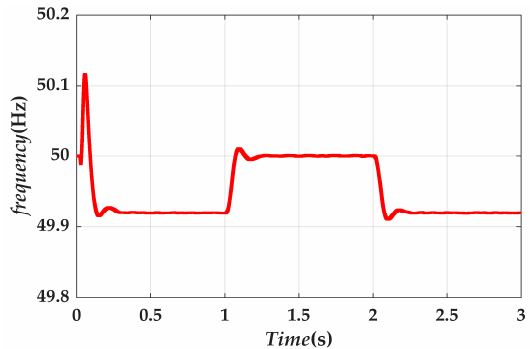
Figure 11. Waveform of active power of self-synchronizing voltage source when grid-connection switching.